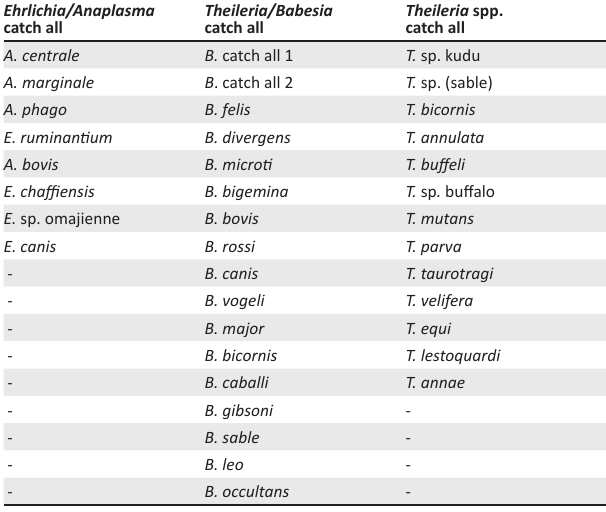
TABLE 1: List of haemoparasites screened for by polymerase chain reaction, reverse line blot method. Ehrlichia/Anaplasma catch all